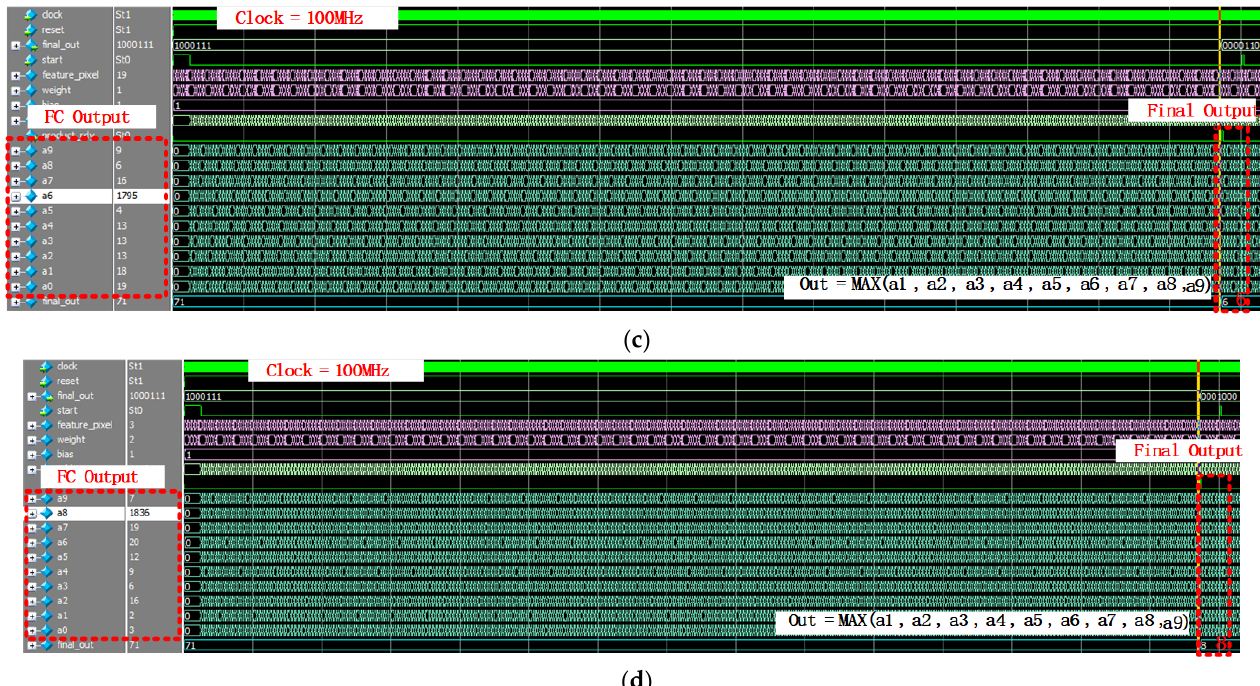
Figure 20. The top simulation results of the proposed CNN system. ( a ) The top simulation result of digit 3. ( b ) The top simulation result of digit 5. ( c ) The top simulation result of digit 6. ( d ) The top simulation result of digit 8.